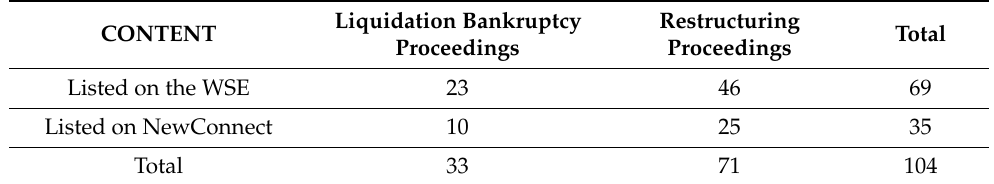
Table 3. Test sample